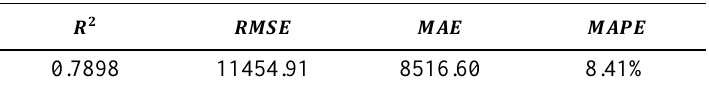
Table 6 shows the performance index values for constructed regression model. Table 6. Regression pricing models results.